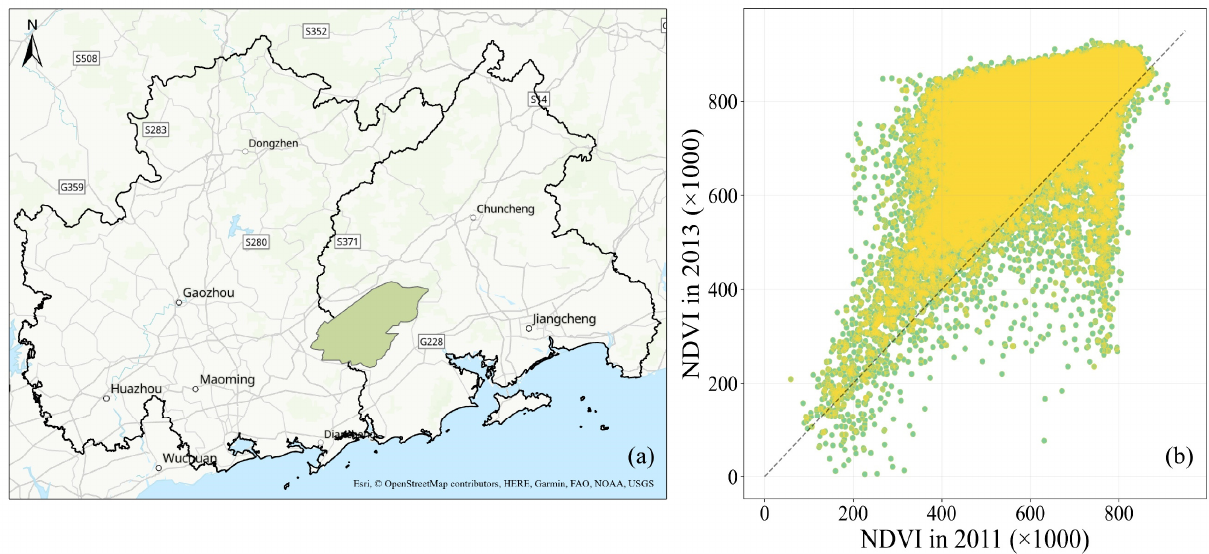
Figure 10. Validation of the NDVI calibration results using the selected area of the Ehuangzhang Nature Reserve in Guangdong Province: ( a ) the geographical location of the test site; ( b ) the comparison between the NDVI values obtained in 2011 using Landsat ETM+ sensor and 2013 using Land OLI sensor.